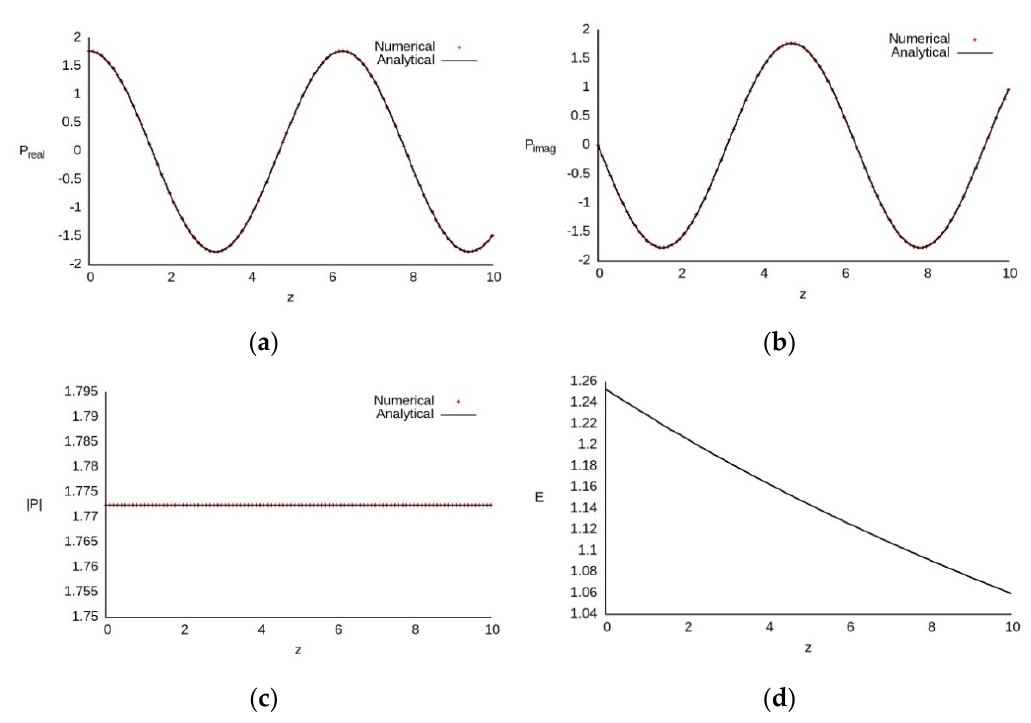
Figure 4. The function P ( z , L t ) (4c) evolution: real part ( a ), imaginary part ( b ), its modulus ( c ), and the pulse’s energy ( d ) obtained via computer simulation (red dotted line) and analytical solution (black solid line) with the parameters D 2 ω = − 0.01, δ 0 = 0, n 0 = 0.01, .